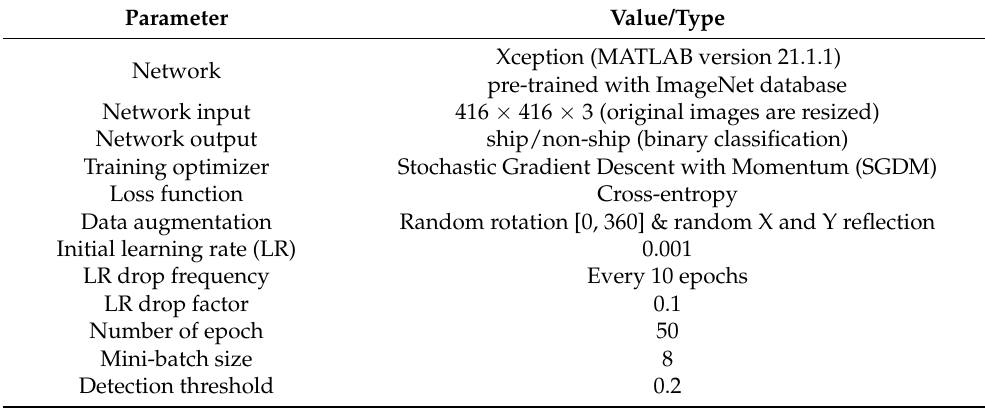
Table 5. The parameters used in the detection stage.